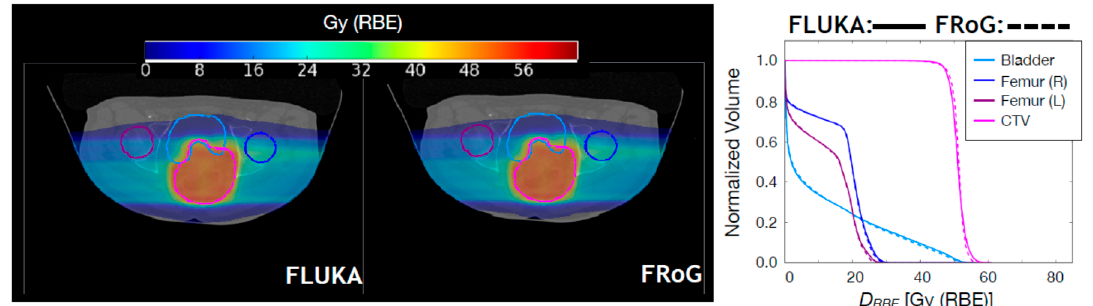
Figure 2. FLUKA and FRoG recalculated D RBE distributions for a proton pelvic case are displayed in the left and middle panel, respectively, together with the contours of four regions of interest: the clinical target volume (CTV), right/left femur, and bladder. The D RBE VH for the ROIs are shown in the right panel.